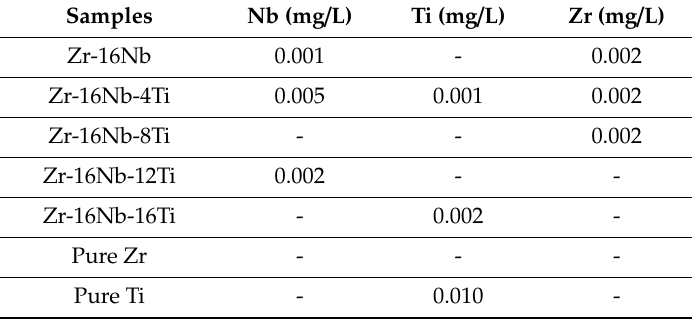
Table 2. Zr, Nb, Ti ion concentration release from pure Zr, pure Ti and the Zr-16Nb-xTi alloys.